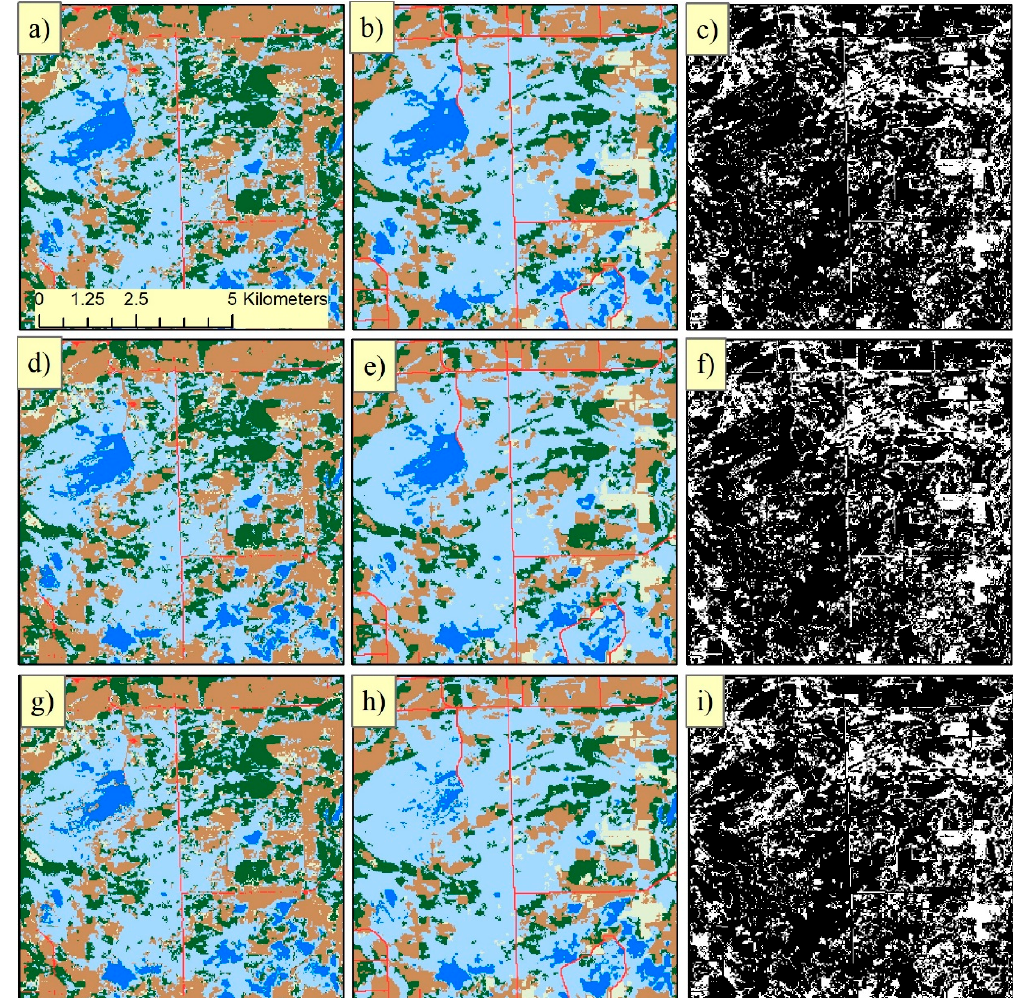
Figure 9. Example of the LCMAP and NLCD products at tile H18V05 in corresponding years: (a) LCMAP-2001; (b) NLCD-2001; (c) difference between LCMAP and NLCD in 2001; (d) LCMAP-2006; (e) NLCD-2006; (f) difference between LCMAP and NLCD in 2006; (g) LCMAP-2011; (h) NLCD-2011; (i) difference between LCMAP and NLCD in 2011. The major land cover classes include Tree (green), Wetland (light blue), Water (dark blue), Grass / Shrub (yellow), Developed (red), and Cropland (brown).